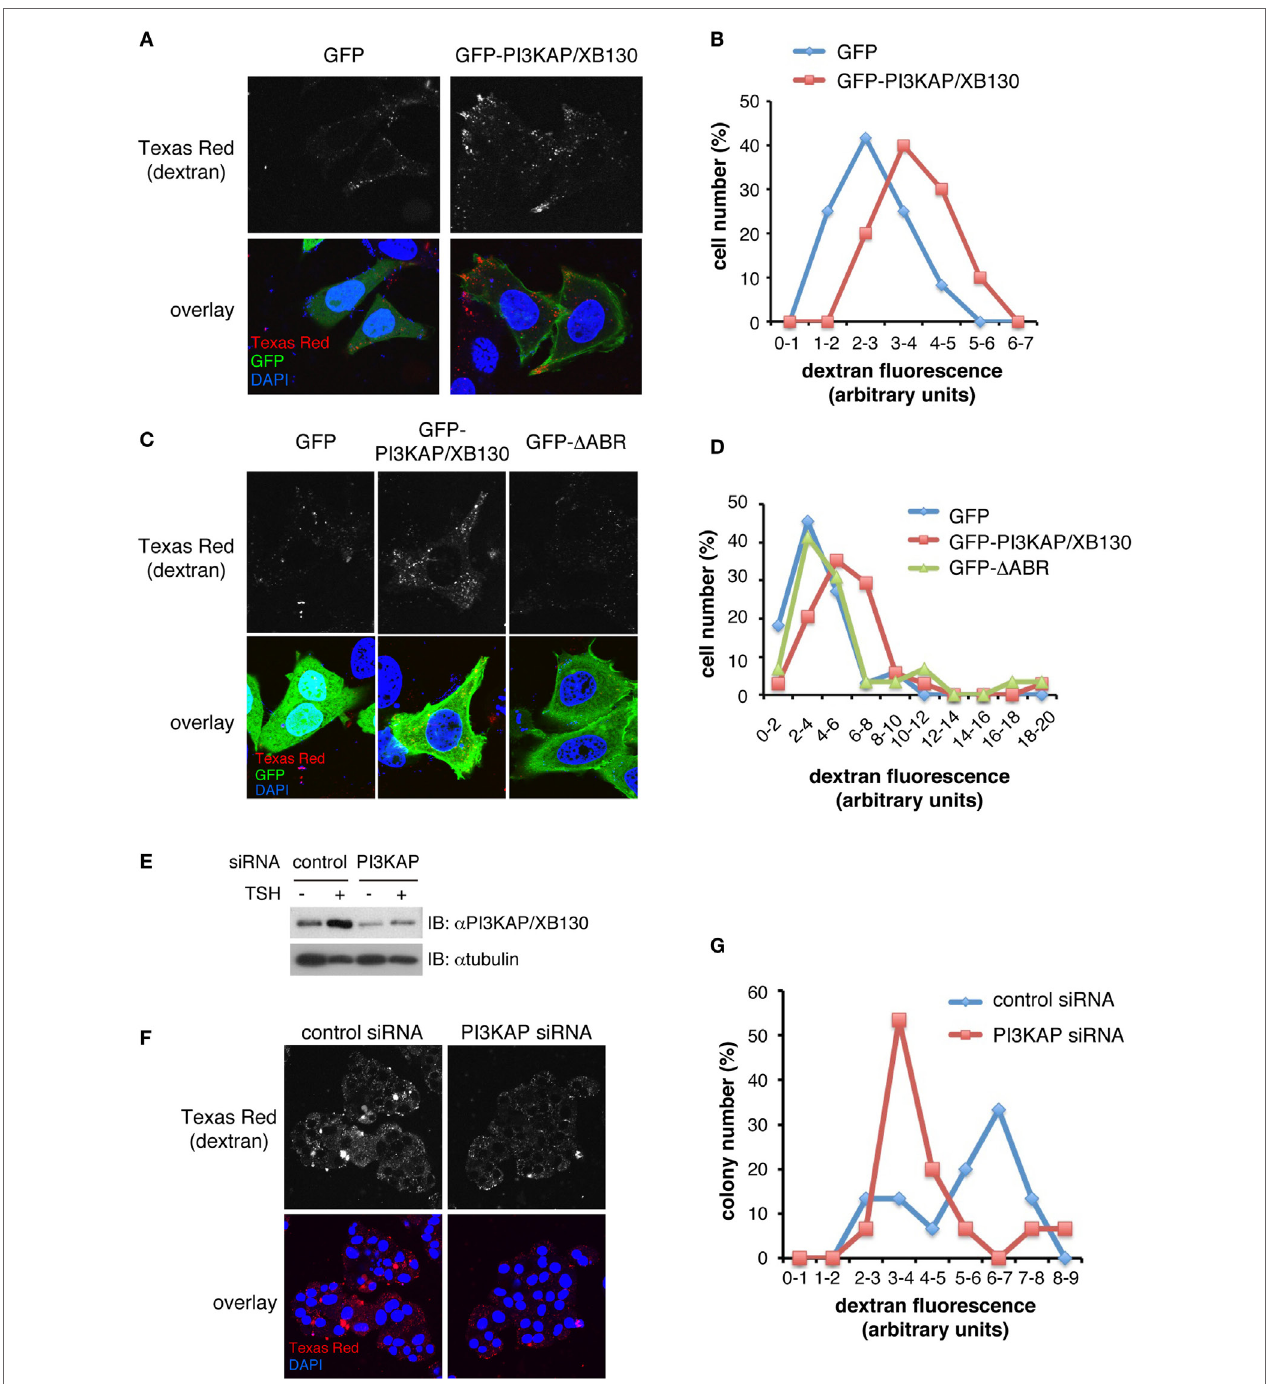
FigUre 6 | Pi3KaP/XB130 promotes dextran endocytosis through the actin-binding region . HEK293 cells were transfected with GFP, GFP-PI3KAP, or GFP- Δ ABR in the presense of 10% FBS for 48 h (a–D) . FRTL-5 cells were transfected with control or PI3KAP/XB130-specific siRNA, serum-starved for 24 h, and treated with 1 nM TSH for 24 h (e–g) . The cells were incubated with 0.2 mg/ml dextran–Texas Red during the last 4 h [HEK293 cells; (a–D) ] or 8 h [FRTL-5 cells; (F,g) ]. After fixation and DAPI staining, dextran–Texas Red incorporated into cells was visualized by confocal microscopy. (a,c,F) Representative images of cells are shown. Gray scale images of Texas Red are indicated in upper panels and overlay images in lower panels (red, Texas Red; green, GFP; and blue, DAPI). (B,D,g) Amounts of dextran–Texas Red incorporated into cells were evaluated by the ImageJ software. The percentage of cells or colonies in each fraction of fluorescent intensity was indicated in histograms. The fluorescent values were analyzed by Student’s t -test [ (B) n = 10–12, (g) n = 15] or by ANOVA followed by Steel–Dwass post hoc test [ (D) n = 30–34]. (e) PI3KAP/XB130 protein levels were analyzed by